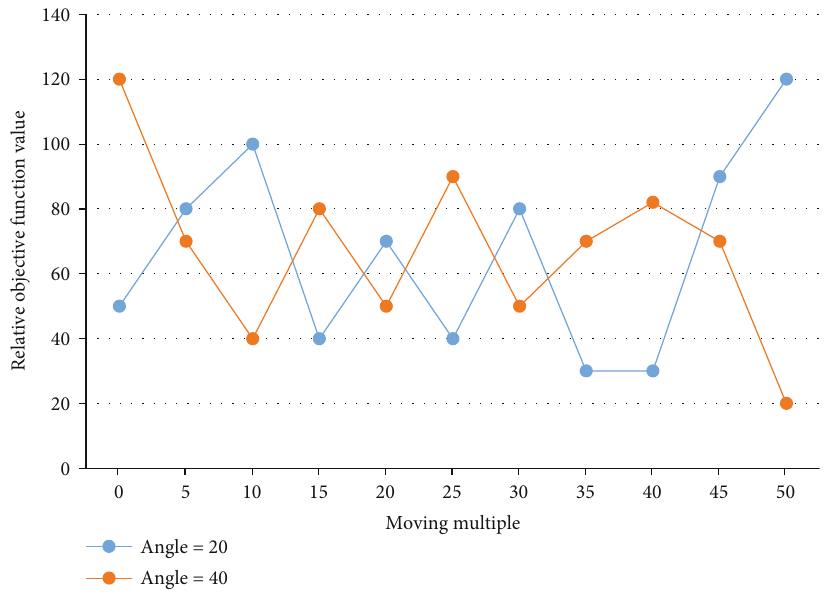
Figure 4: Registration results in parallel direction.